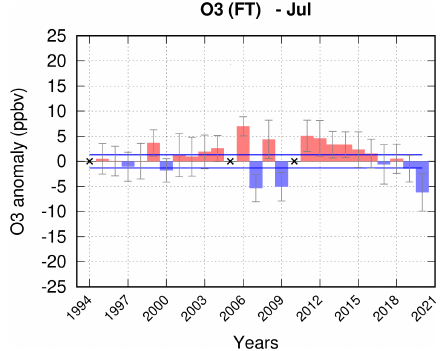
Figure A1. Ozone anomalies in the free troposphere (830–350hPa) for the month of July since 1994. The grey bars represent the 95% confidence limits, and the blue horizonal lines represent the inter- annual variability.